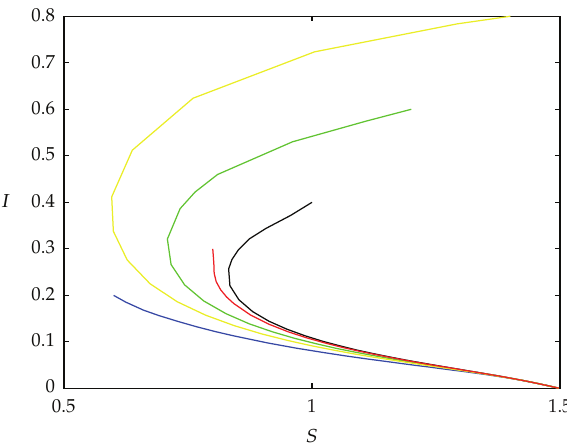
Figure 3: Phase diagram of S (cid:3) t (cid:4) with di ff erent initial values and parameters ρ (cid:7) 0 . 3 , μ (cid:7) 0 . 2 , β (cid:7) 1 . 5 , α (cid:7) 1 , r (cid:7) 0 . 5 , d (cid:7) 0 . 2 , ω (cid:7) 0 . 1 , and τ (cid:7)